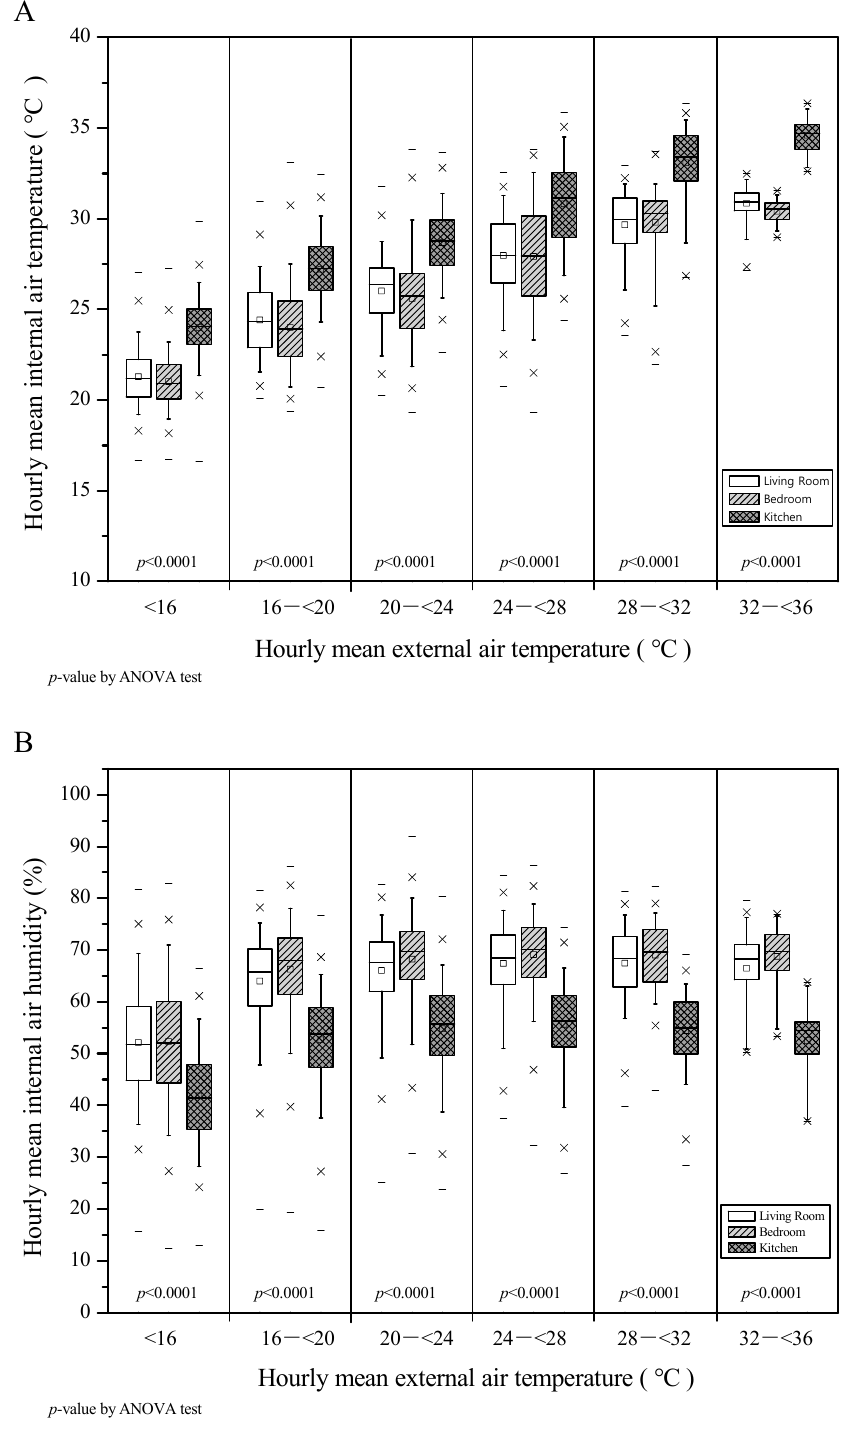
Figure 2. ( A ) Internal vs. external air temperature and ( B ) internal air humidity vs. external air temperature in the eight monitored apartments during a period of one year (Boxplots indicate the minimum, first quartile, median, third quartile, and m max); p -value was calculated using a one-way ANOVA